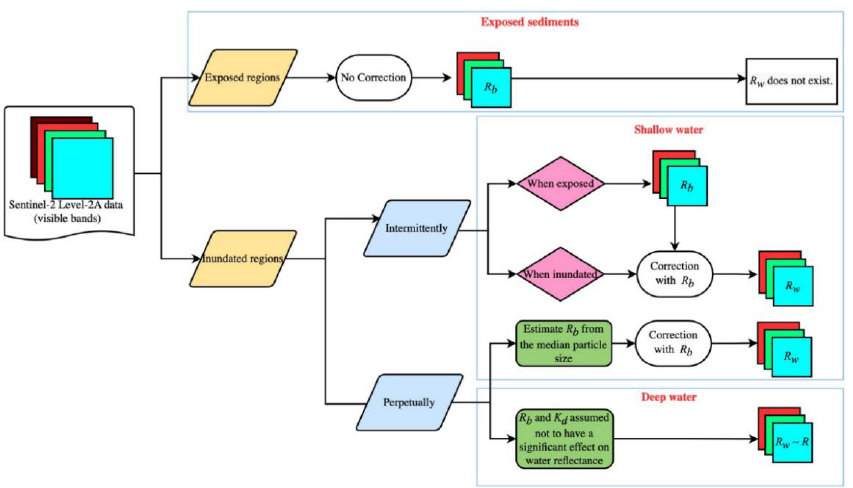
Figure 2. Flow diagram showing how pixels are treated with respect to extracting the bottom and water reflectance, depending on whether they are permanently, temporally or never